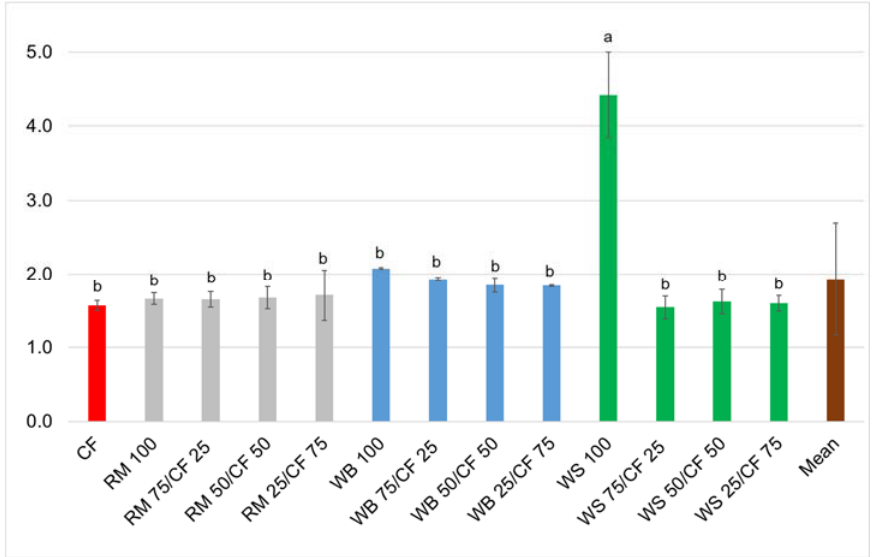
Figure 4. Feed-conversion ratio (FCR) depending on the type of feed, results on a fresh basis; CF (chicken feed), RM (rapeseed meal), WB (wheat bran) and WS (willowleaf sunflower); a, b, c ... letters mean that the values are statistically different (Tukey’s test at p < 0.05).